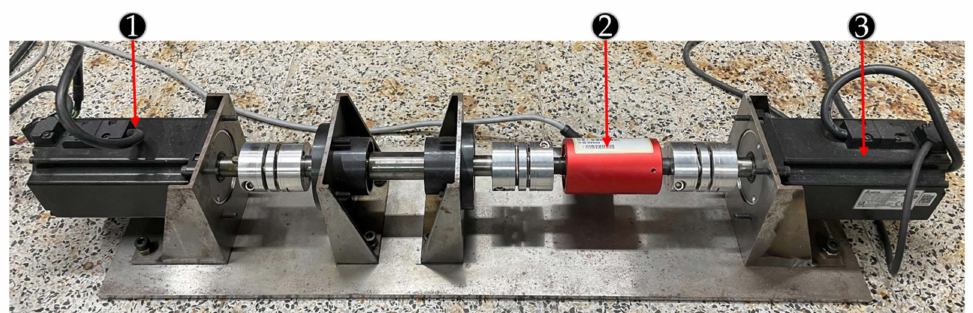
Figure 1. Motor testing platform: (1) motor I; (2) speed sensor; and (3) motor II.